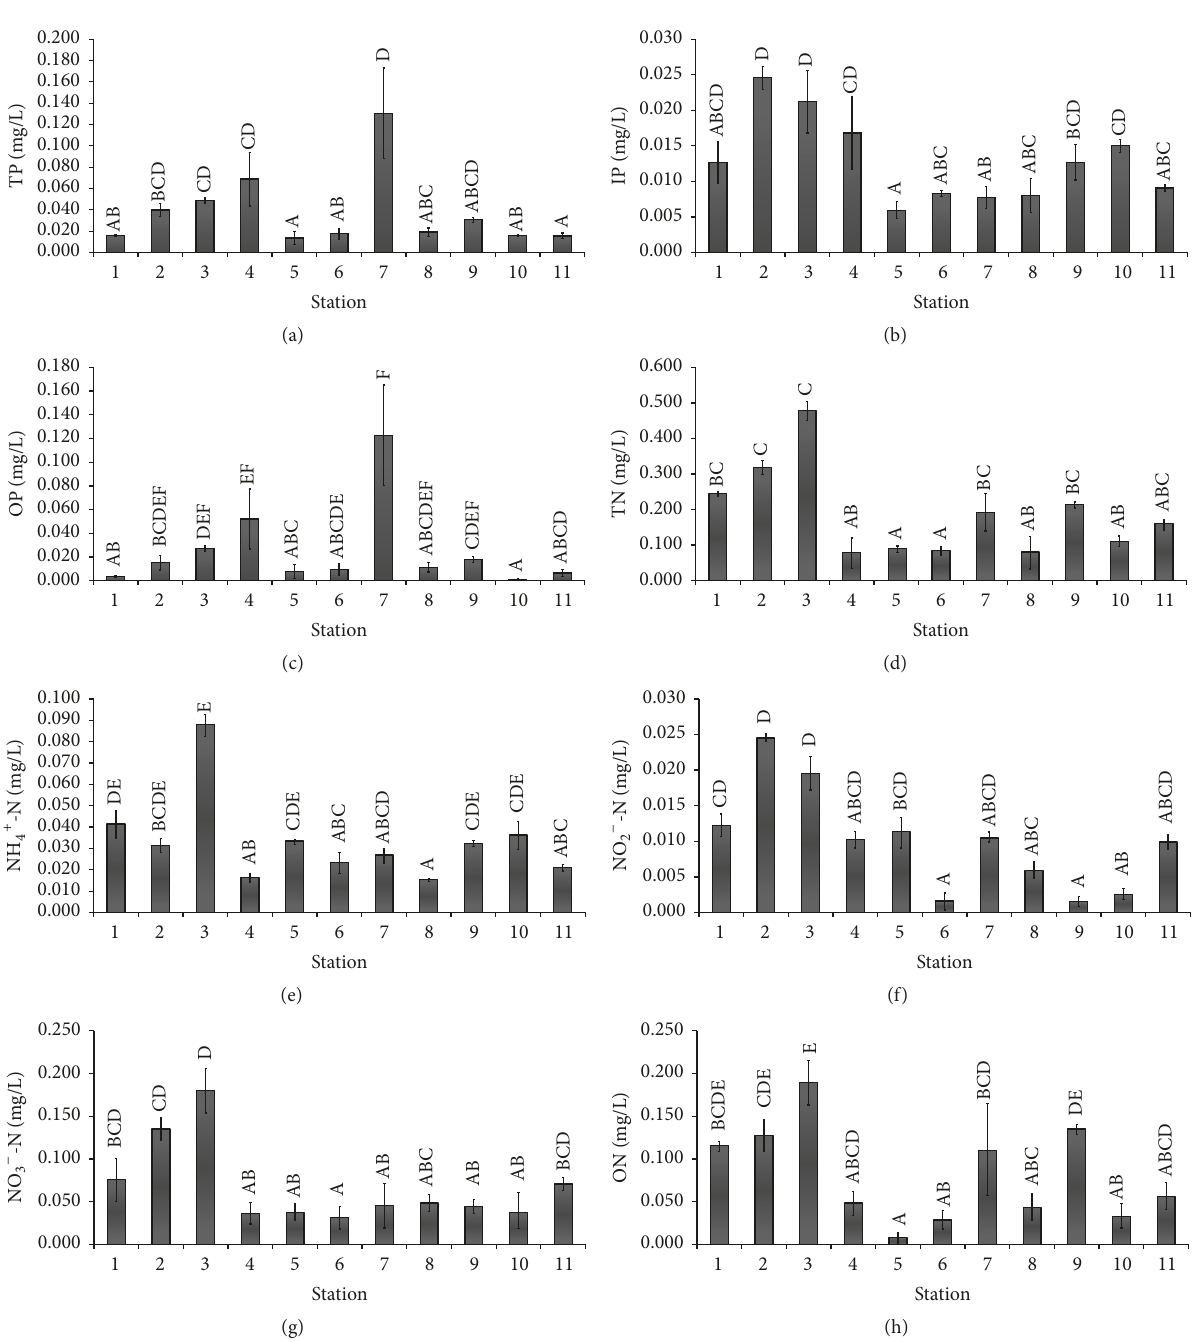
Figure 4: Water quality parameters include (a) TP, (b) IP, (c) OP, (d) TN, (e) NH 4+ -N, (f) NO 2− -N, (g) NO 3− -N, and (h) ON along the coastline of southwestern Sarawak. The same letter indicates no significant difference between the stations ( p value >